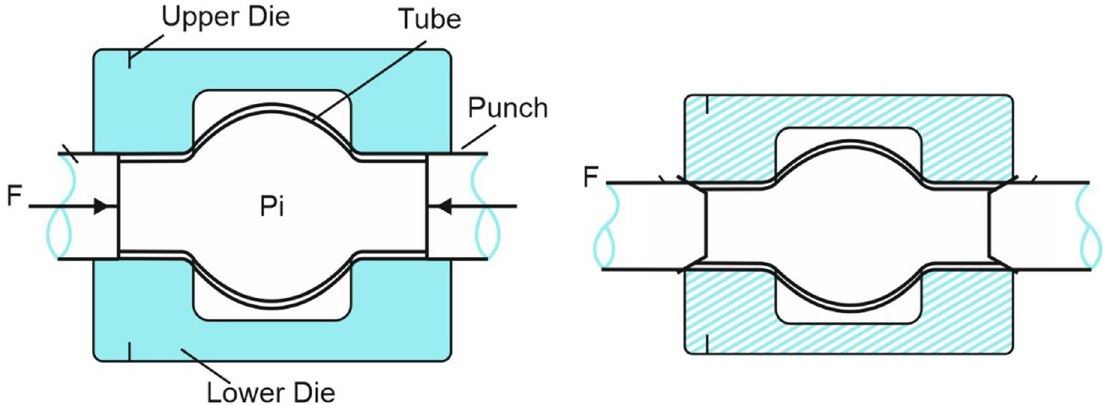
Fig. 12 Axial and fixed feed